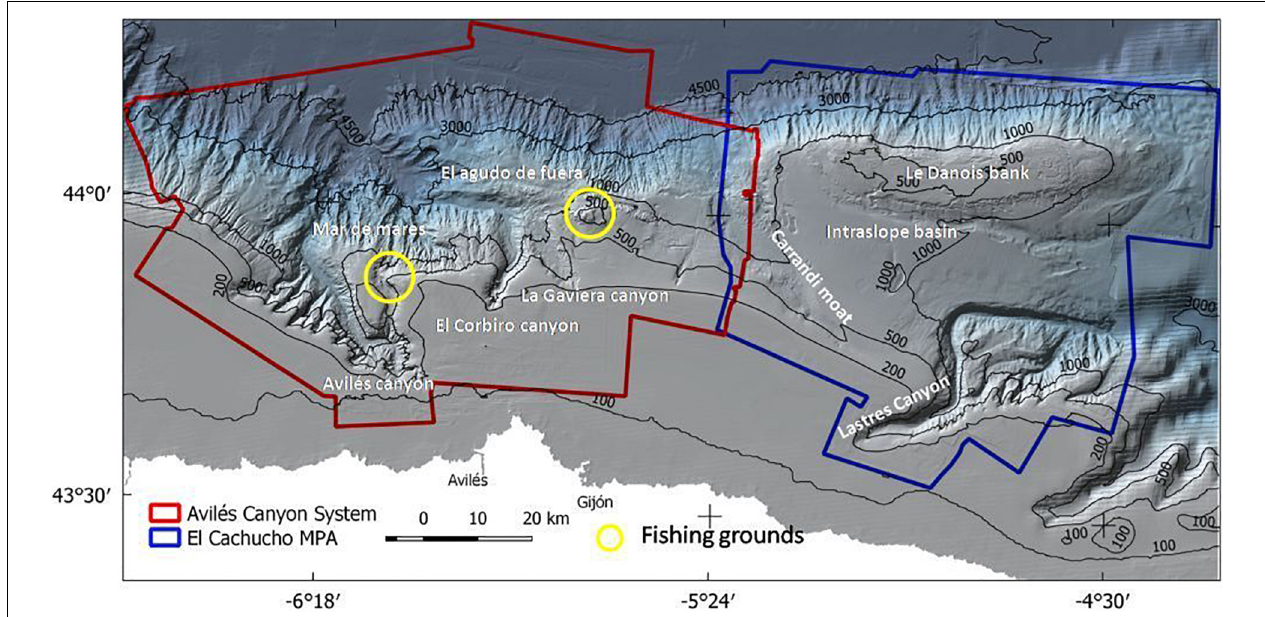
FIGURE 2 | Map of the study area comprising the Avilés Canyon System and the El Cachucho